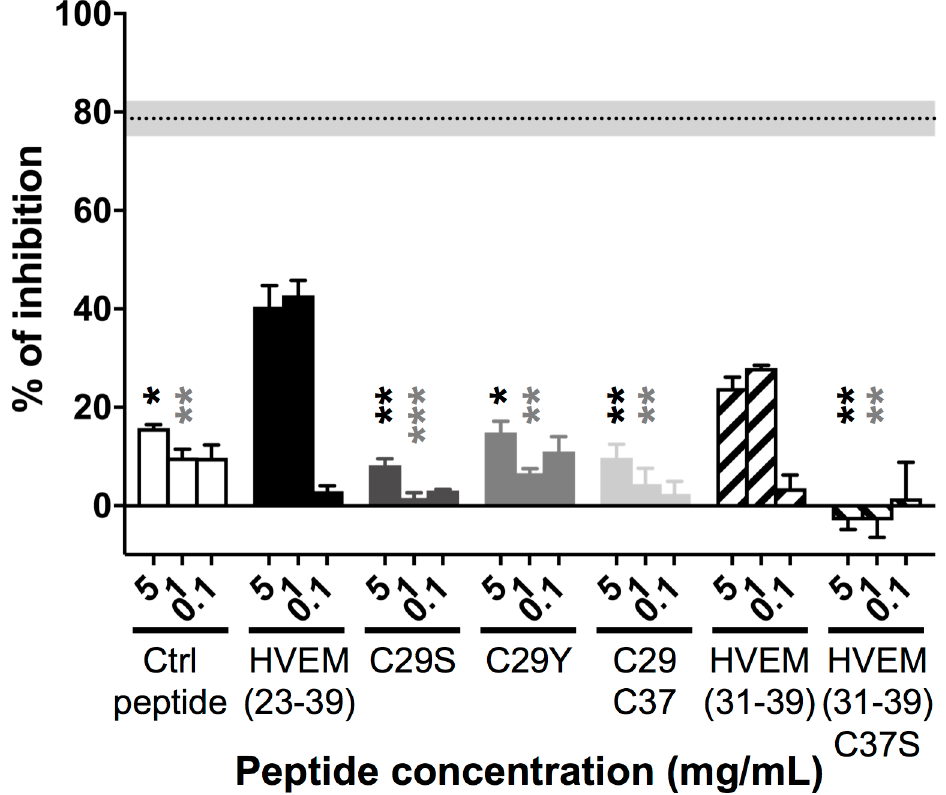
Fig 5. Cysteinesfrom HVEM(23–39) are the main amino acid residues involved in the inhibition of BTLA/HVEM interaction. Increasingconcentrations of HVEM(23–39) or HVEM(31–39) modifiedpeptides, where one or both cysteines were substituted, were tested in ELISA and compared to correspondingwild-type and scrambled(Ctrl peptide)peptides (at least two experiments in triplicate). The percentageof inhibitionof the BTLA/HVEM bindingwas calculatedin relationto the negative control (PBS). Statistical analysiswas performed by comparing each concentration of each peptideto the same concentration of wild-typepeptide HVEM(23–39). ** : p < 0.01 followingnon-parametric One-way ANOVA and